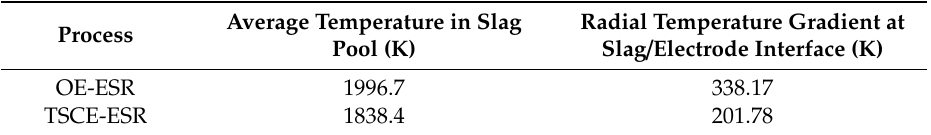
Figure 9. Velocity field and temperature field distribution in slag pool. ( a ) Velocity field of OE-ESR. ( b ) Temperature field of OE-ESR. ( c ) Velocity field of TSCE-ESR. ( d ) Temperature field of TSCE-ESR. Table 2. Average temperature in the slag pool area and the radial temperature gradient at the slag / electrode